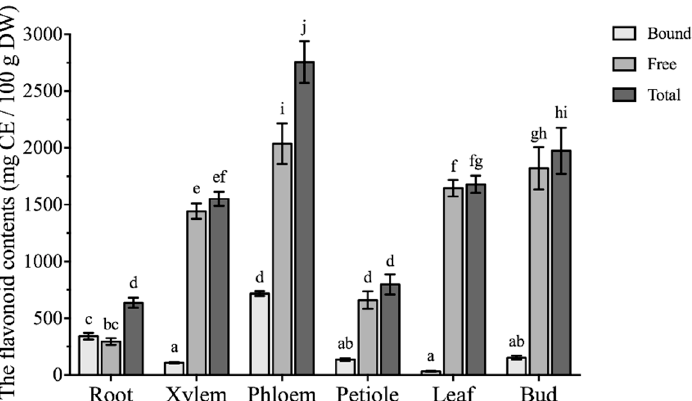
Figure 3. The flavonoid contents of different vegetative parts from Boehmeria nivea L. (mean ± SD, n = 3). Bars with different letters indicate significant differences among the samples (p < 0.05).